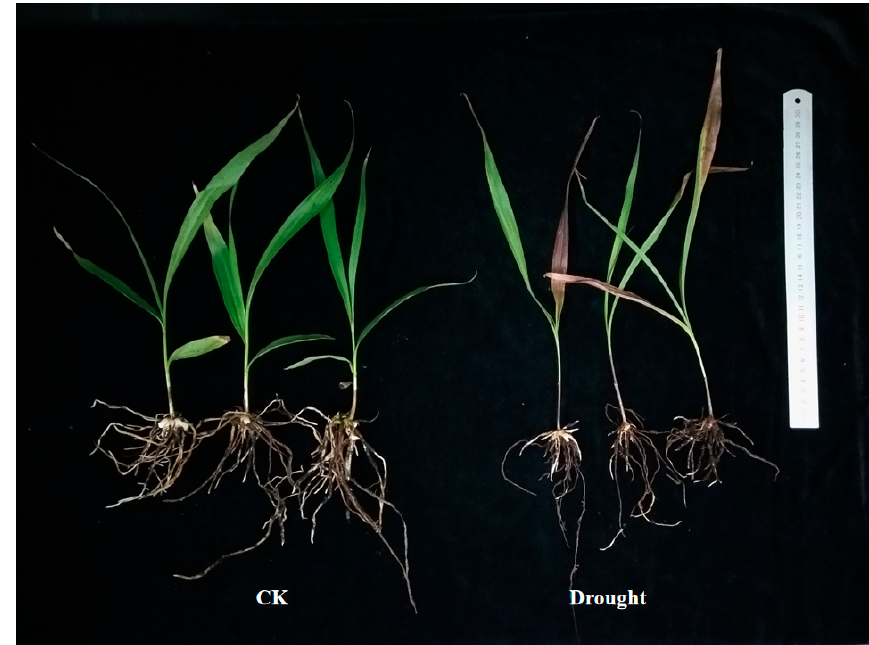
Figure 1. Images of B. striata under normal (CK) and drought conditions.